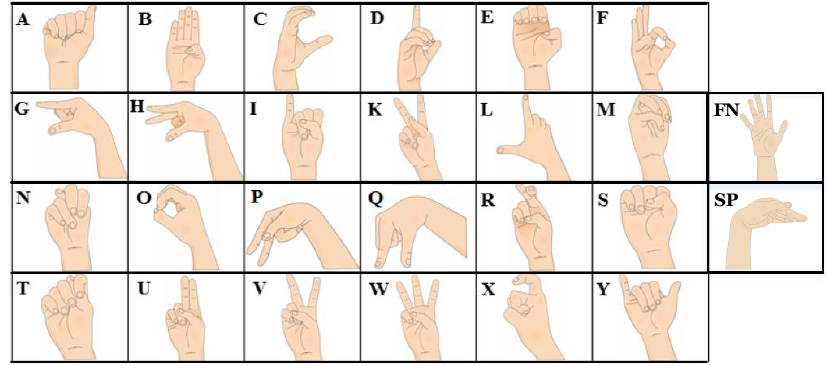
Figure 5. American Sign Language alphabet used in ASLYset. A sample of the generated ASLYset resized to 352 × 352 can be seen in Figure 6.